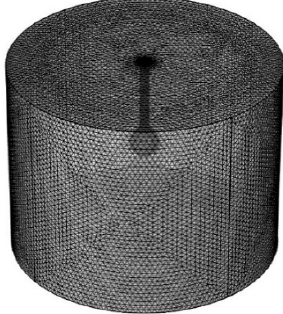
Figure 6. Classification model of shielding fittings.